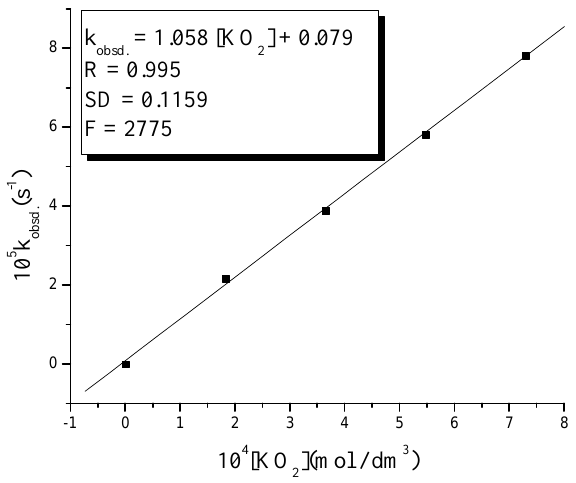
Figure 2. Pseudo-first order kinetics of the reaction between DPPH and KO presence of 18C6 at 25ºC (the first 25